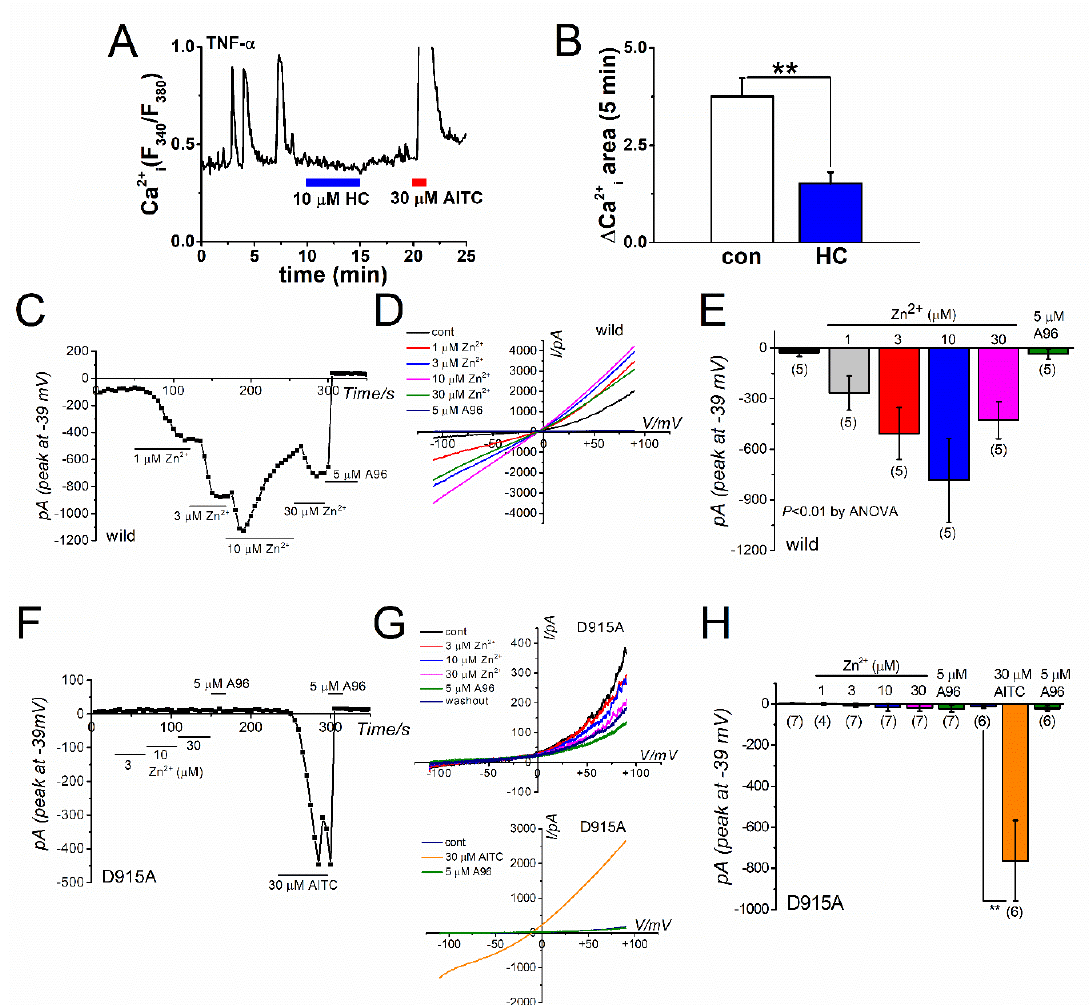
Figure 1. Zn 2+ -dependent TRPA1 activation. ( A ) Intrinsic Ca 2+ oscillations sensitive to the TRPA1 antagonist HC observed on treating inflammatory FLSs with 10 U TNF- α for 24 h. Presence of the TRPA1 agonist AITC (30 μM) evoked a